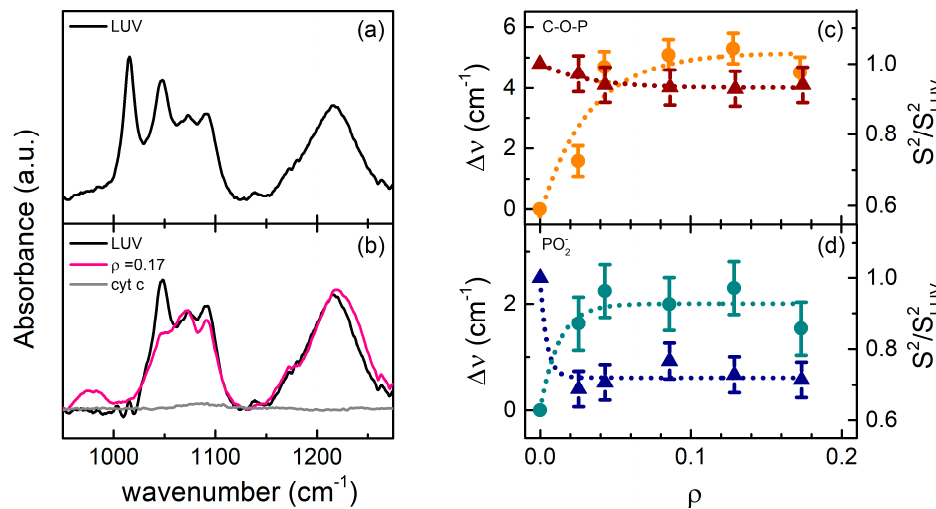
Figure 4. ( a ) ATR-IR spectrum of freshly prepared LUV solution; ( b ) ATR-IR spectra of LUV before (black) and after (pink) cyt c interaction, compared to the spectrum of the pure cyt c (gray). Spectra were normalized to unit area; ( c ) C-O-P Δν frequency shift (orange circles) and S 2 values (dark red triangles) normalized to those of LUV solutions as a function of ρ ; ( d ) PO (cid:2870)(cid:2879) Δν frequency shift (cyan circles) and normalized S 2 values (blue triangles) of PO (cid:2870)(cid:2879) groups. In ( c , d ) panels, data were fitted with exponential curves, reported as dotted guides to eyes.